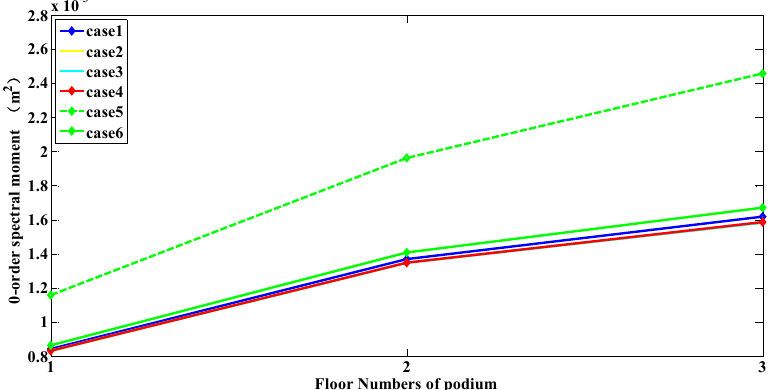
Figure 9. Zero-order spectral moment of the displacement of each layer of the podium .